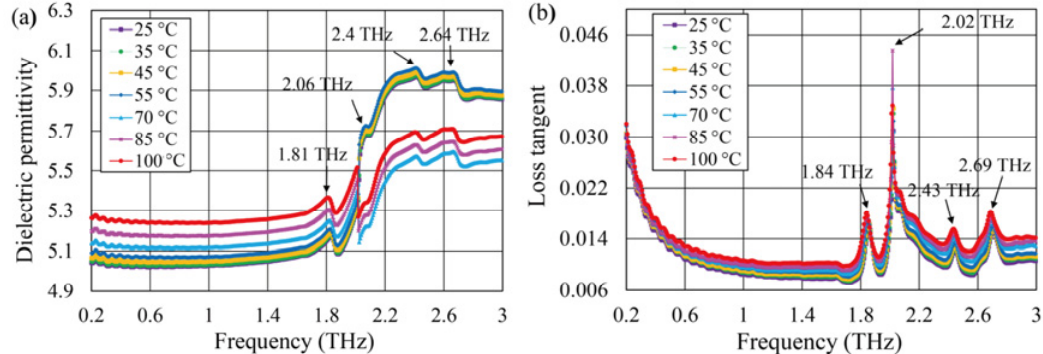
Fig. 8 Dielectric permittivity (a) and loss tangent (b) versus frequency in the range of 0.2–3 THz for a few temperatures in the range of 25–100 ℃ for Li 2 WO 4 ceramics sintered at 610 ℃